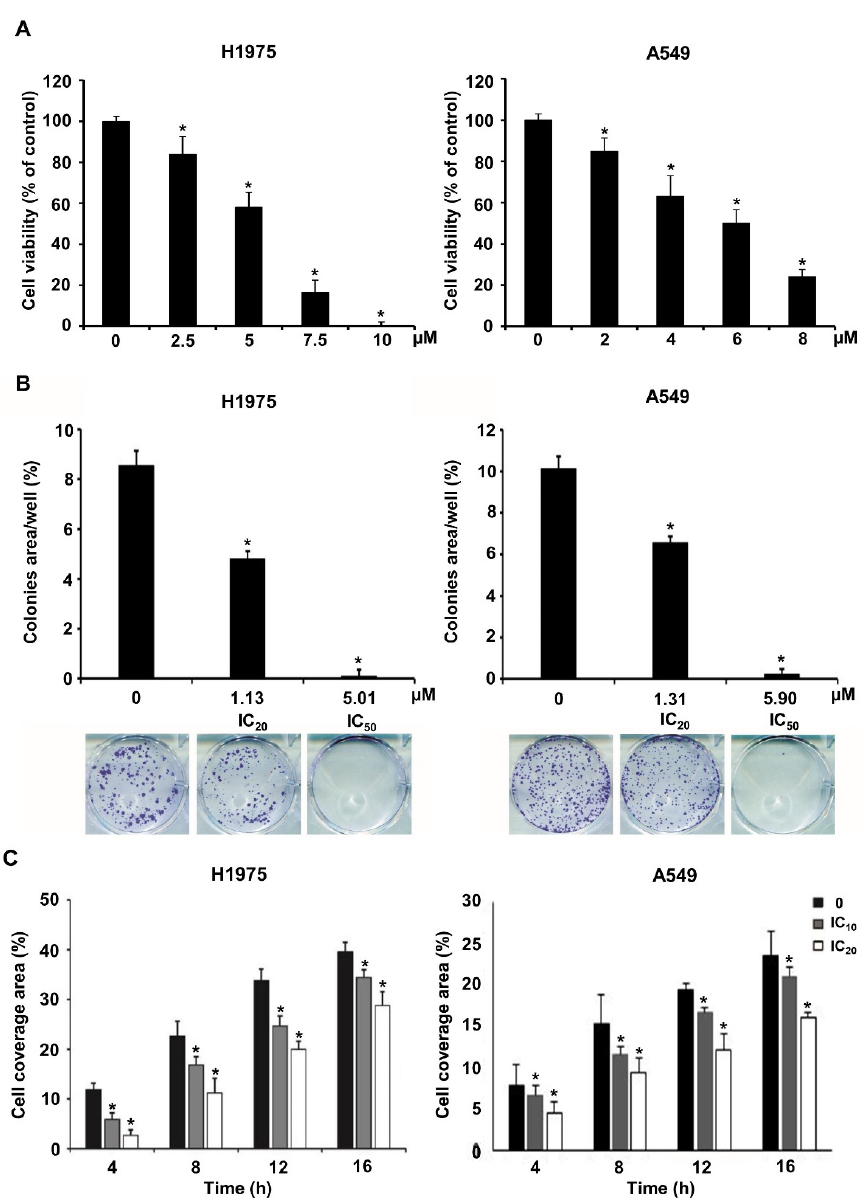
Figure 5. The impact of NSC609077 on lung cancer cell viability, clonogenicity, and motility. ( A ) The cytotoxicity of NSC609077 was evaluated in H1975 and A549 lung cancer cells with a cell viability assay. The results are shown as the percentages with respect to the control response (0 µ M). ( B ) H1975 and A549 cells grown under anchorage-dependent conditions were treated with IC 20 and IC 50 of NSC609077 for 48 h and then evaluated through clonogenic assays. Quantification of the percentage of the colony-covered area of each treatment group, as assessed with ImageJ software. Representative images are shown. ( C ) The effect of IC 10 (H1975, 0.47 µM; A549, 0.55 µM) and IC 20 (H1975, 1.13 µM; A549, 1.31 µM) of NSC609077 treatment for 16 h on H1975 and A549 cell migration was assessed by scratch-wound assay. The percentage of the cell coverage areas was measured. * p < 0.05 compared with the vehicle-treated control.